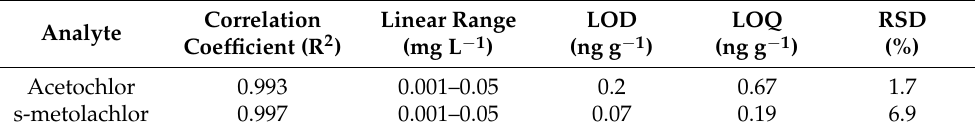
Table 2. Analytical characteristics of the optimized Accelerated Solvent extraction (ASE)/GC-MS method for the two herbicides.